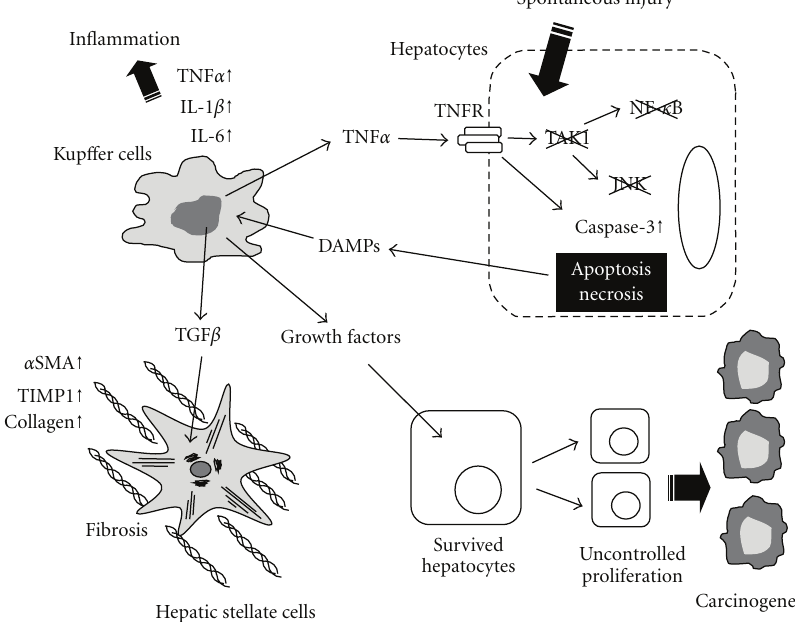
Figure 2: Ablation of TAK1 in hepatocytes induces spontaneous liver injury, inflammation, fibrosis, and cancer. Spontaneous hepatocyte death occurs in hepatocyte specific TAK1-deficient mice followed by the release of damage-associated molecular patterns (DAMPs) which stimulate Kup ff er cells to produce TNF- α . This TNF- α further induces cell death in TAK1-deficient hepatocytes lacking activation of NF- κ B and JNK. TNF- α , IL-1 β , and IL-6 released from Kup ff er cells cause liver inflammation. Kup ff er cell-derived TGF- β stimulates hepatic stellate cells resulting in fibrogenesis. The persistent hepatocyte death and uncontrolled compensatory proliferation in the livers of hepatocyte specific TAK1-deficient mice induce the reactivation of onco-fetal liver genes that are associated with the initiation of hepatic